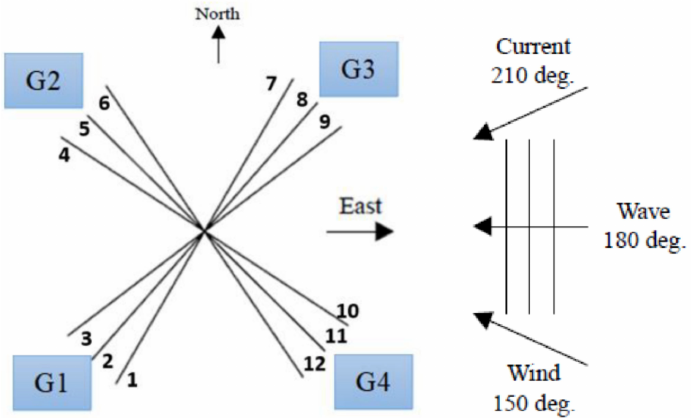
Figure 4. Illustration of wave, wind, and current